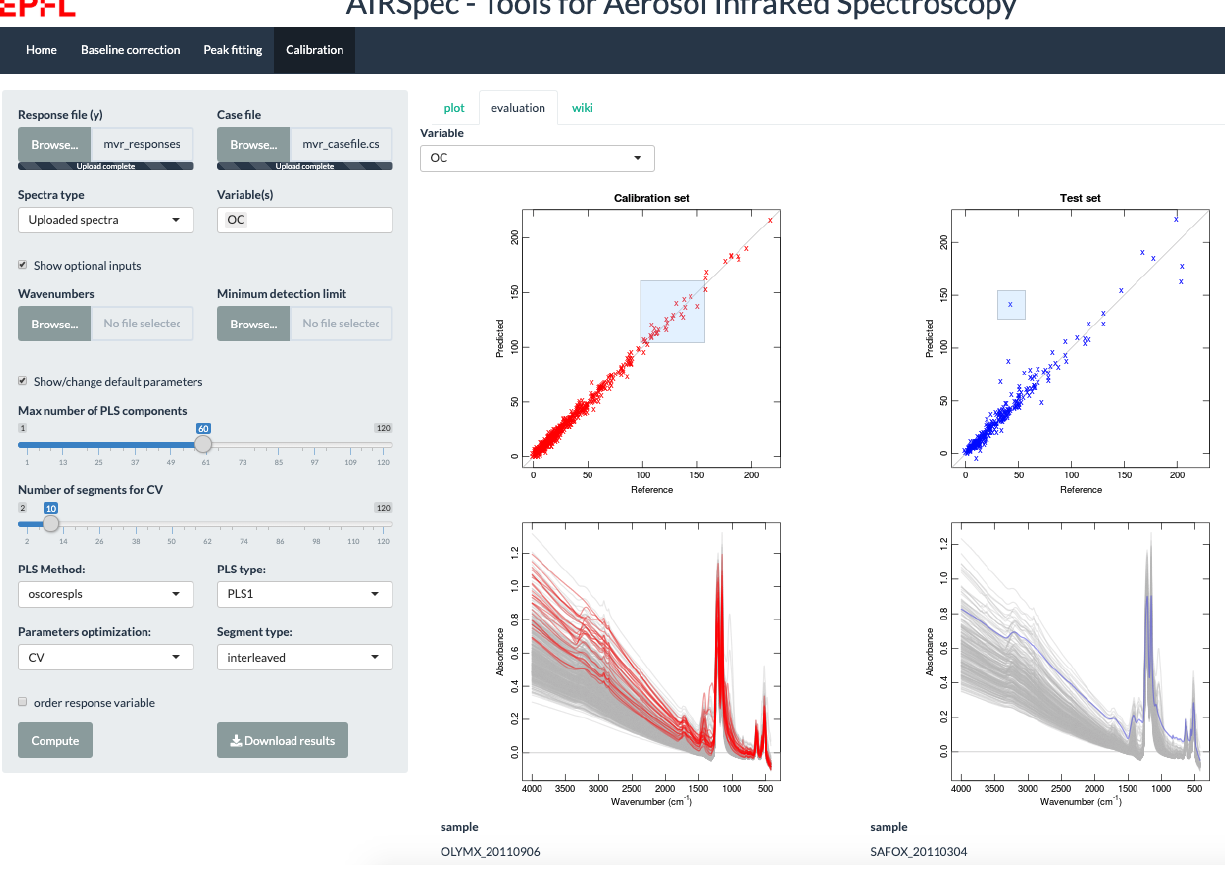
Figure 7. AIRSpec calibration package